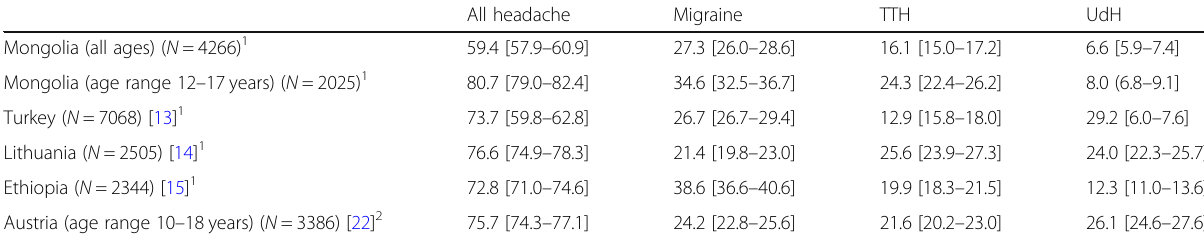
Table 6 1-year prevalences (% [95% CI]) of all headache, migraine, tension-type headache and undifferentiated headache in this and other studies using the same questionnaire All headache Migraine TTH Mongolia (all ages) ( N = 4266)